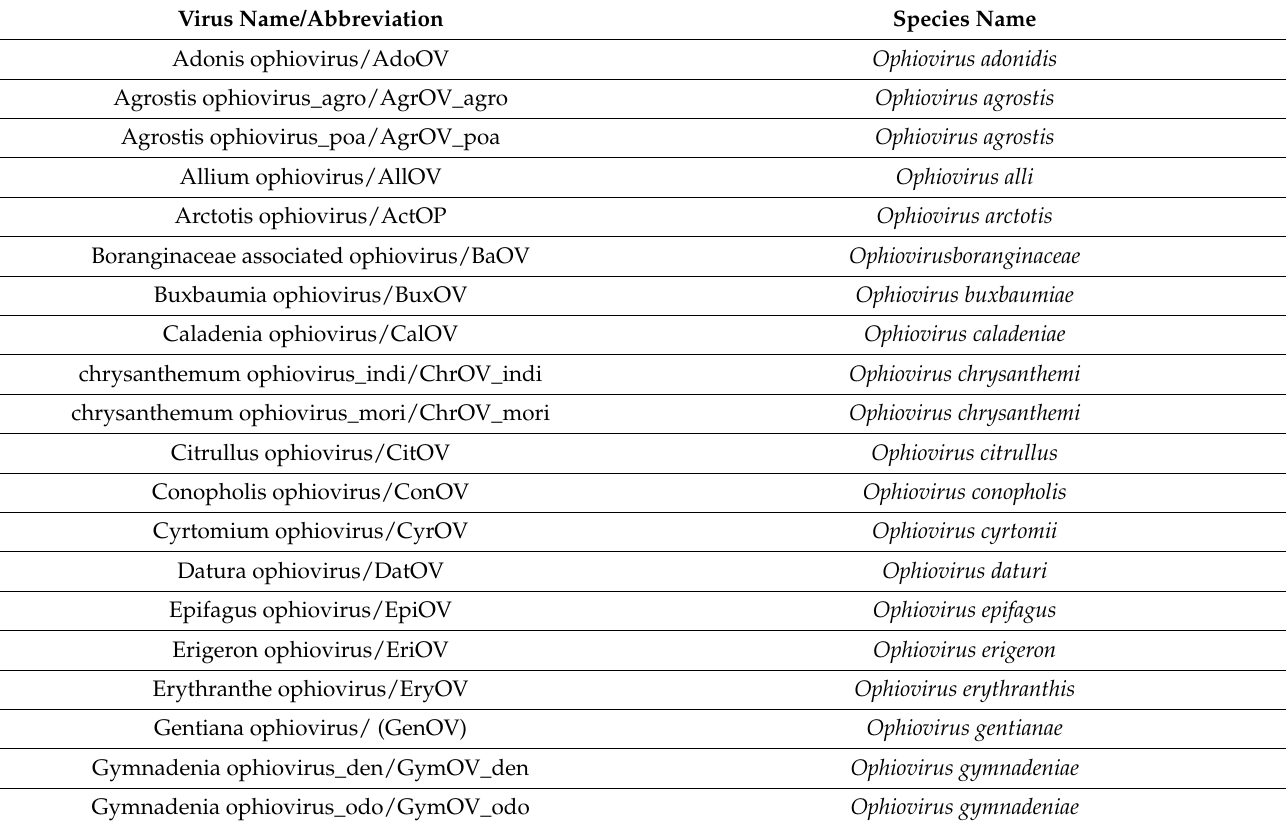
Table 2. Novel viruses: virus name and tentative species names within genus Ophiovirus